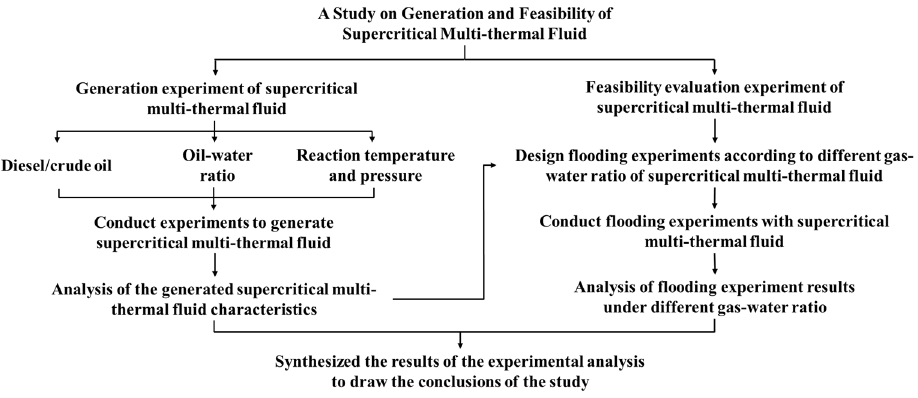
Figure 1. General sketch of this study.